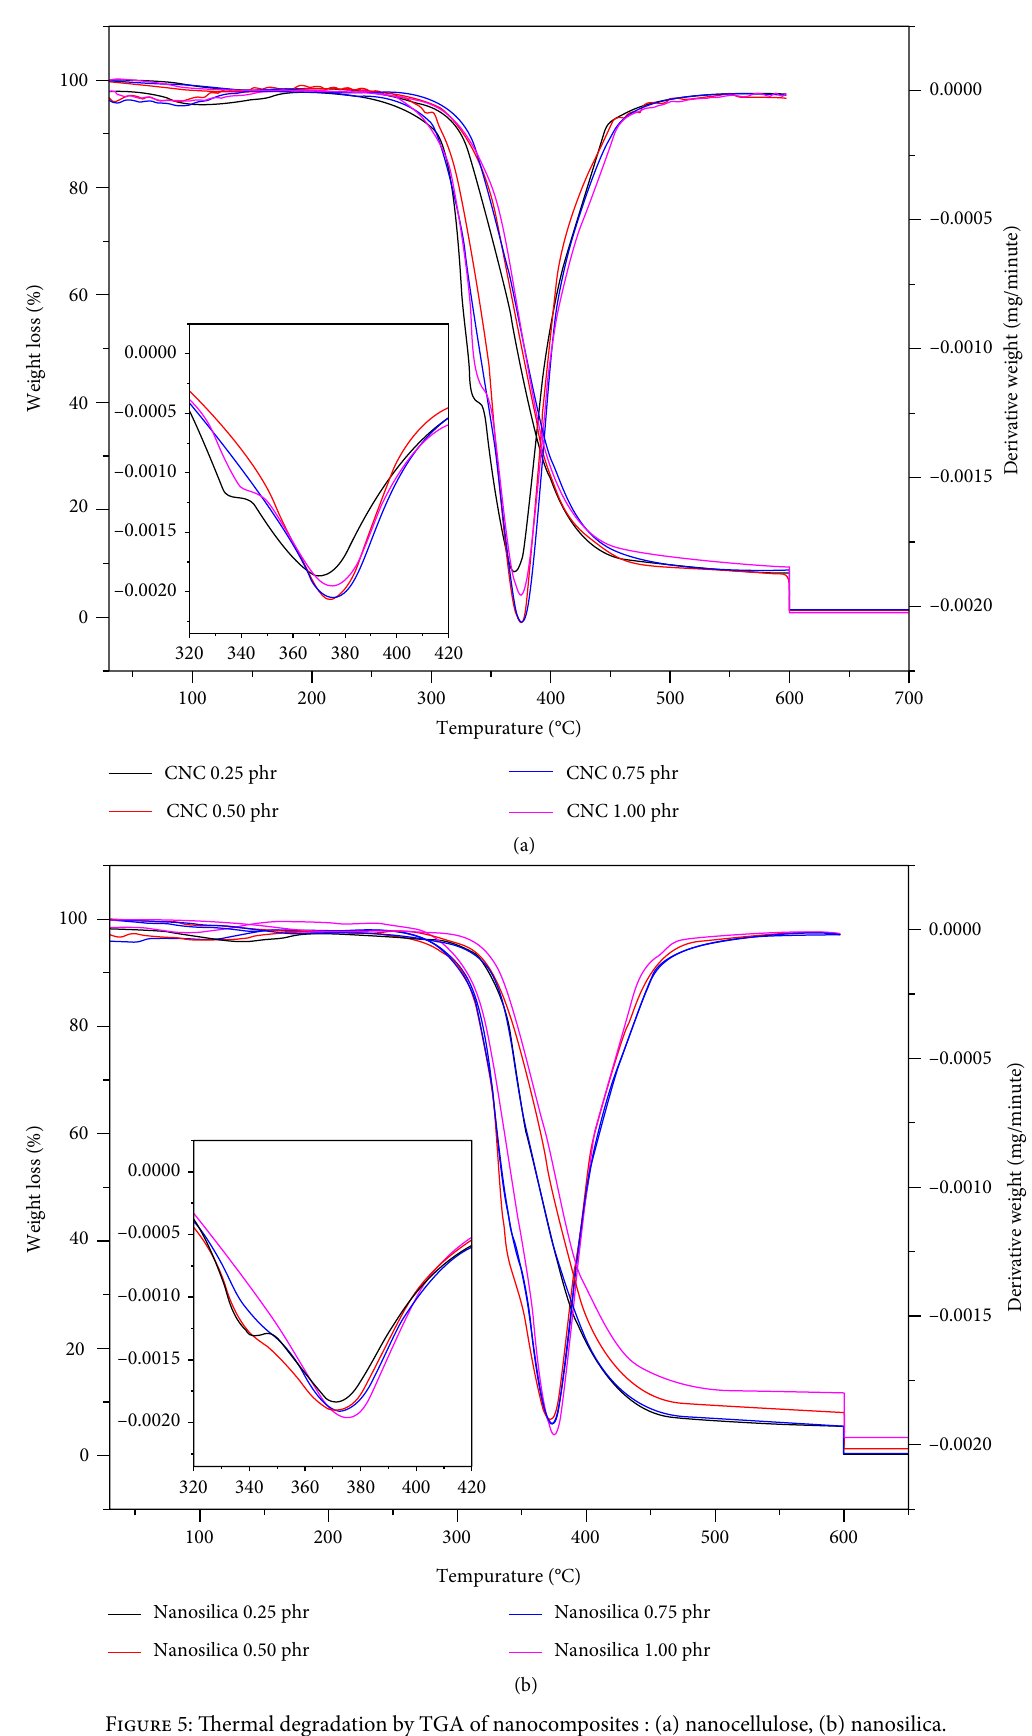
Figure 5: Thermal degradation by TGA of nanocomposites : (a) nanocellulose, (b)